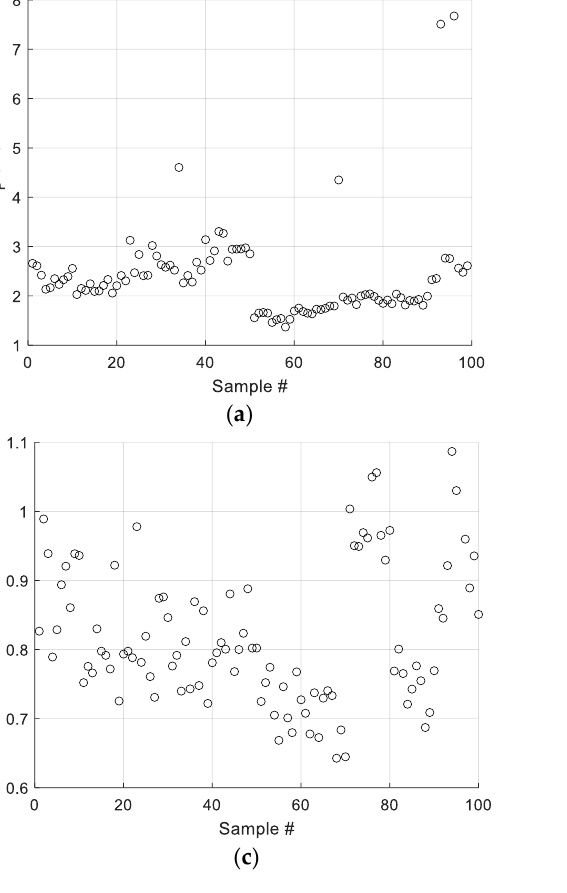
( d ) Figure 9. Results of the robustness test for particle rotation angle: relative residuals between the estimated and nominal values of each parameter vs. the rotation angle for ( a ) perimeter, ( b ) area, ( c ) long and ( d ) short axis.